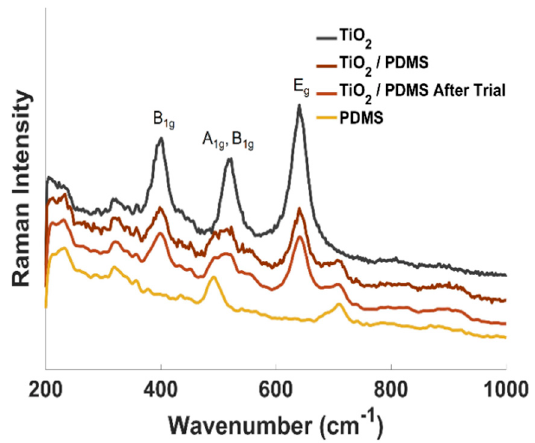
Figure 2. Raman spectrum of pure anatase TiO 2 , TiO 2 /PDMS after synthesis, TiO 2 /PDMS after three consecutive 3-h long degradation trials, and inert PDMS beads.